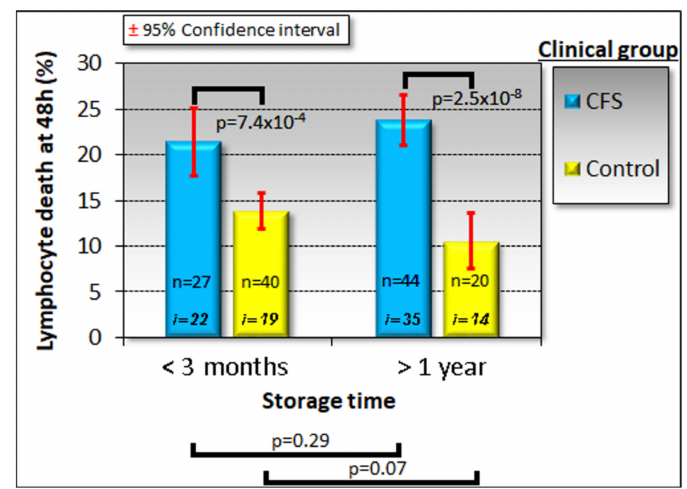
Figure 1. Time in frozen storage has no e ff ect on the viability of lymphocytes after recovery and incubation in culture medium for 48 h. Some individuals were sampled on more than one occasion and some samples were tested at more than one storage time point using separately frozen aliquots. The sample sizes indicated (n) are the number of frozen aliquots that were tested from the number of individuals shown ( i ). Since the storage time had no e ff ect in either ME / CFS patient or control samples, multiple samples tested from the same individual were averaged for subsequent analysis. The fraction of dead cells was greater in ME / CFS lymphocytes. Significance probabilities shown are from pairwise t tests of the di ff erence in means.